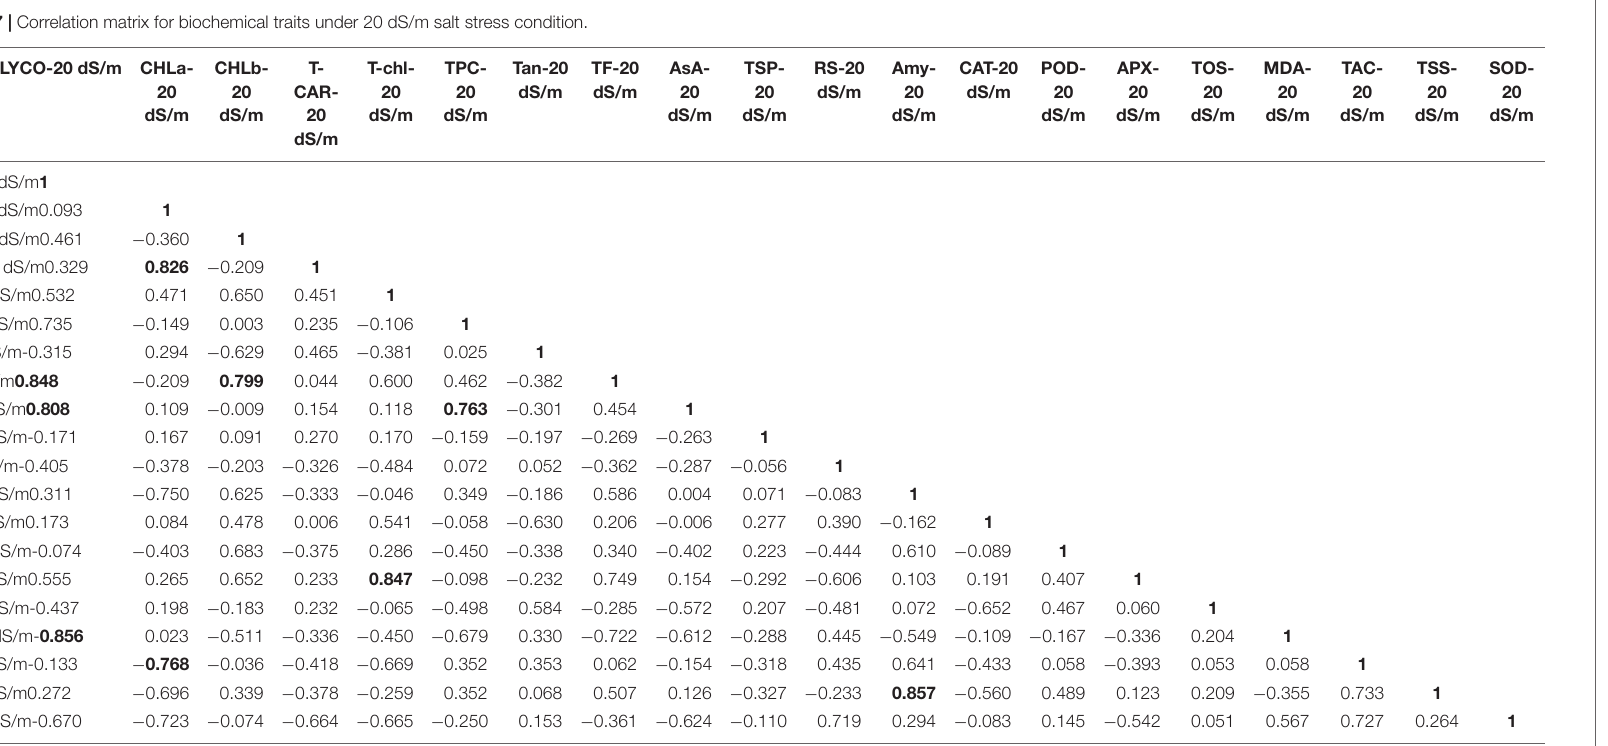
SOD-20 dS/m-0.670 Values in bold are different from 0 with a significance level alpha =